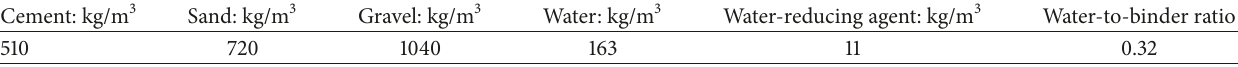
Table 1: Mix proportions of